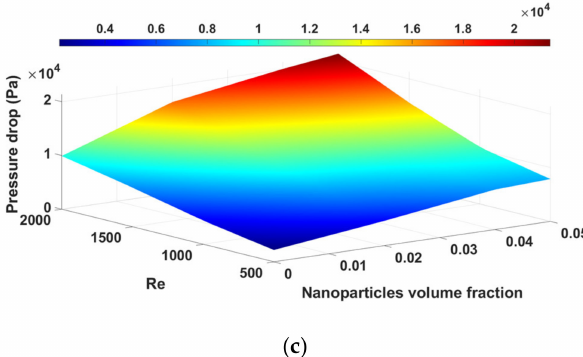
Figure 11. Pressure drop versus Reynolds number, nanoparticle volume fraction, and channel turns number: ( a ) 4 turns, ( b ) 6 turns, and ( c ) 8 turns—results for each subfigure were obtained from 20